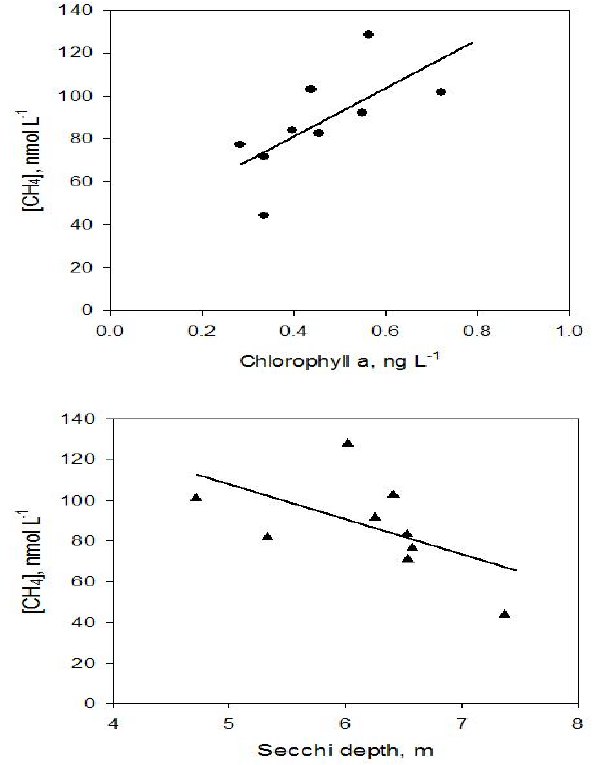
Fig. 6. Mean monthly CH 4 vs. chlorophyll (upper panel) and CH 4 vs. Secchi depth (lower panel). The mean monthly CH 4 and chloro- phyll data were calculated for 25m. Note that the CH 4 data were shifted by one month (see Fig. 4) to account for the apparent time lag of one